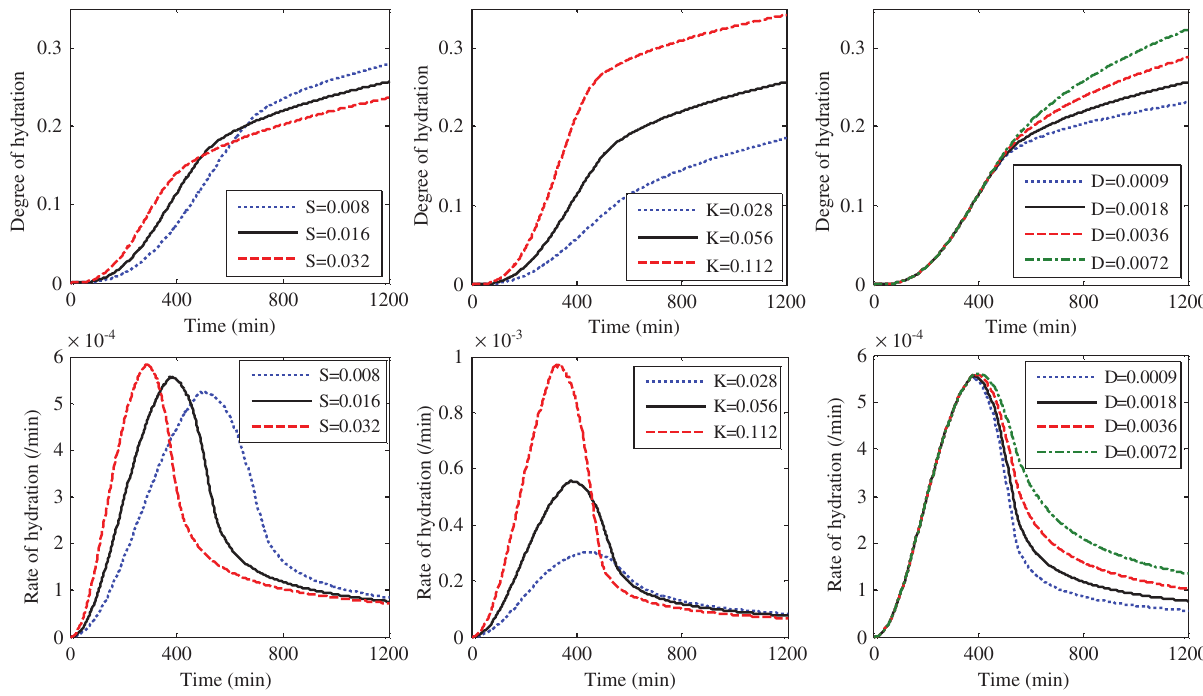
Figure 4 Effect of different model parameters on total hydration kinetics curves (the units of S , K, and D are h -2 , μ m/h, and μ m 2 /h,